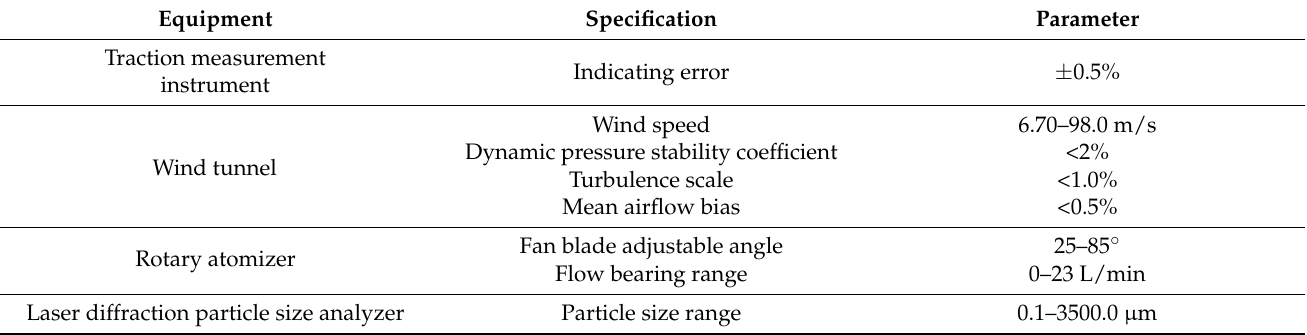
Table 1. Experimental equipment and